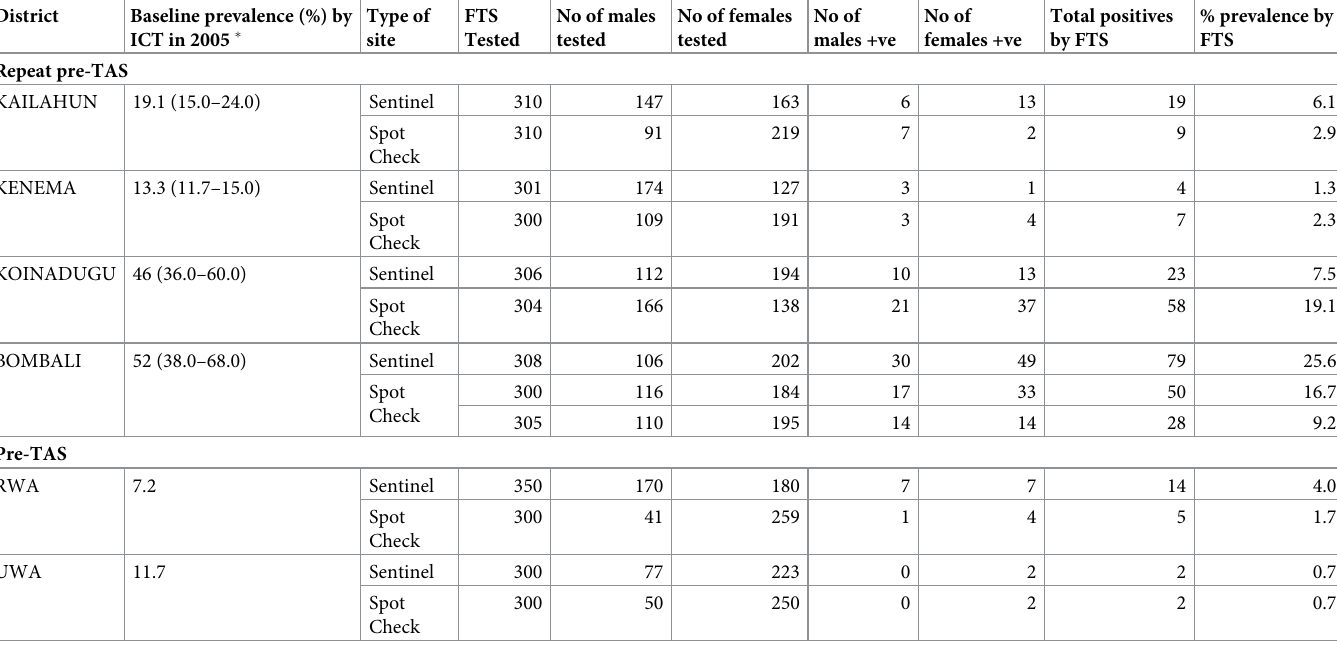
Table 2. Results of repeat pre-TAS and pre-TAS by survey site in six districts in Sierra Leone in 2017. District Baseline prevalence (%) by ICT in 2005 �